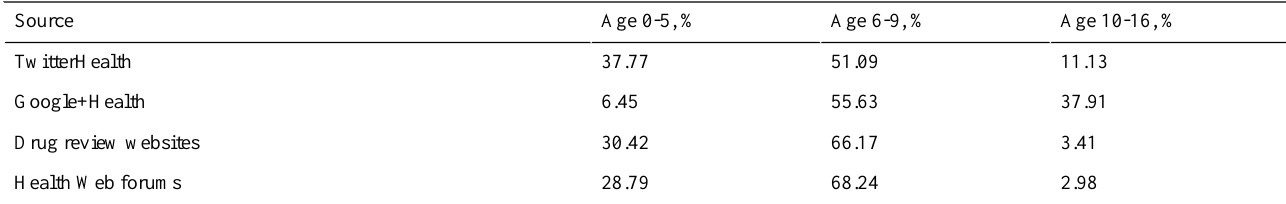
Table 7. Writing level distribution for TwitterHealth, Google+Health, drug reviews, and health